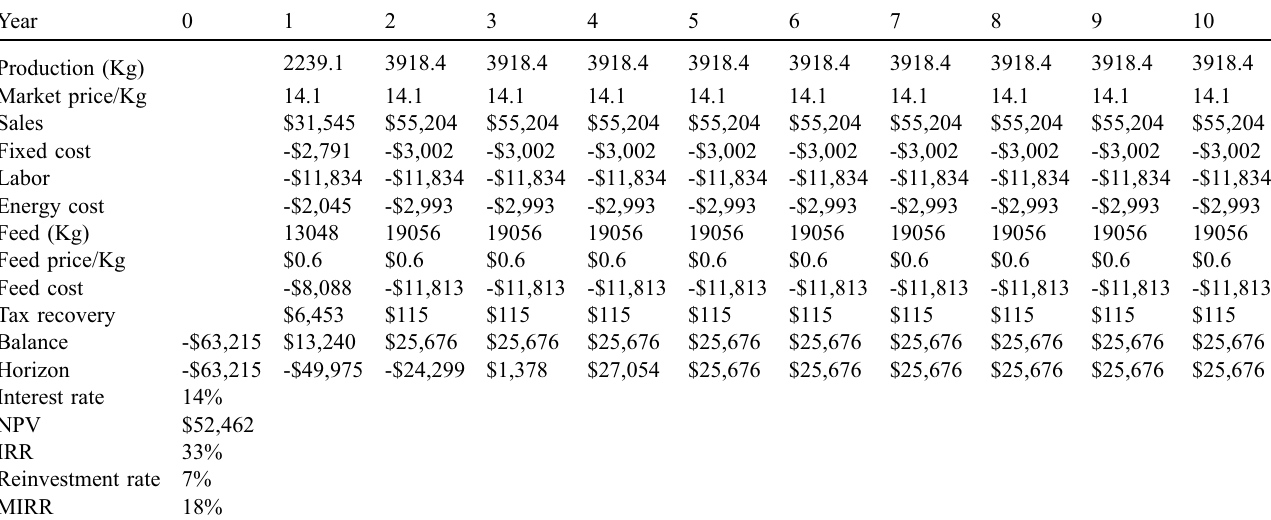
Table 3. Cash fl ow for ten years and calculation of Net Present Value (NPV) and Modi fi ed Internal Return Rate (MIRR) for the base scenario.